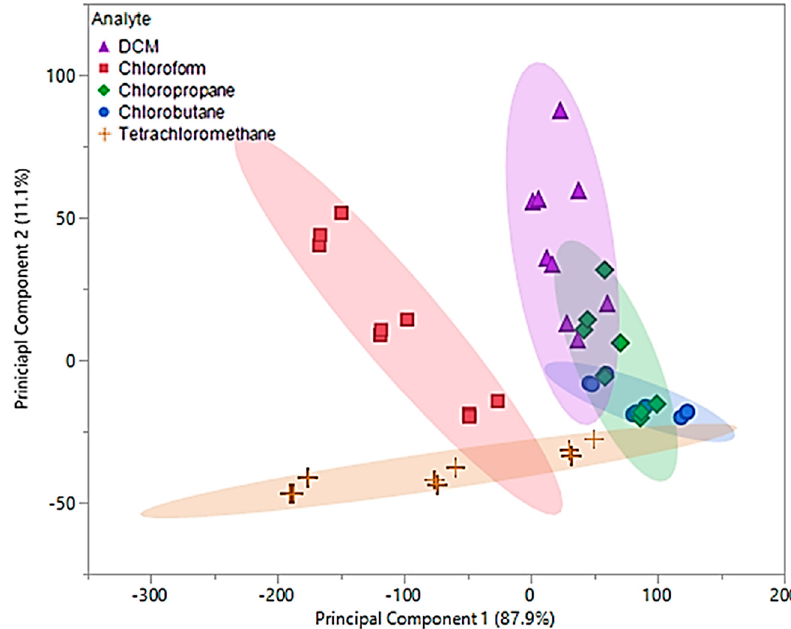
Figure 7. Principal component plot for discrimination of five chlorinated VOCs with respect to a three sensor MSA. Plot considers 45 total measurements consisting of three replicate measurements at three different flow ratios for each VOC (nine measurements per sample) using pure IL sensors.